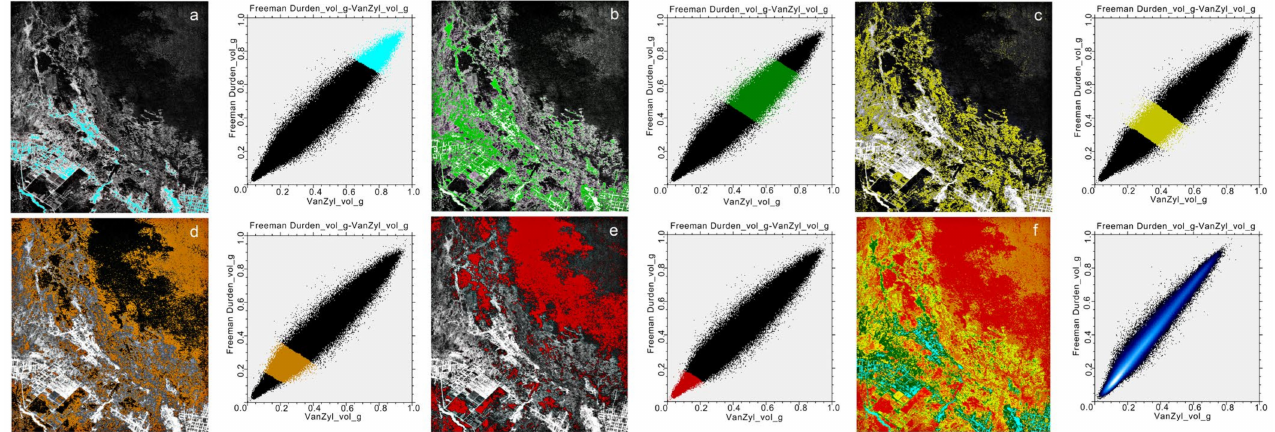
Figure 8. Illustration of different feature types and soil salinization contents in images in the VFD feature space: ( a ) water bodies; ( b ) plant cover; ( c ) slight salinization; ( d ) moderate salinization; ( e ) severe salinization; ( f ) spatial distribution patterns of different levels of soil salinization.